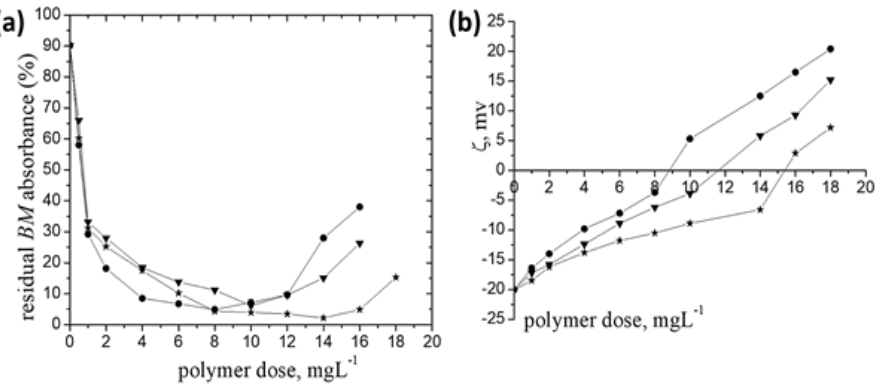
Figure 2. The residual BM absorbance (%) ( a ) and zeta potential ( ζ ) ( b ) dependence on the polycation dose: P- g -pAPTAC1 (inverted triangle), P- g -pAPTAC2 (star), P- g -pAPTAC3 (circle); c BM (%, w / w )— 0.05, settling time 60 min.